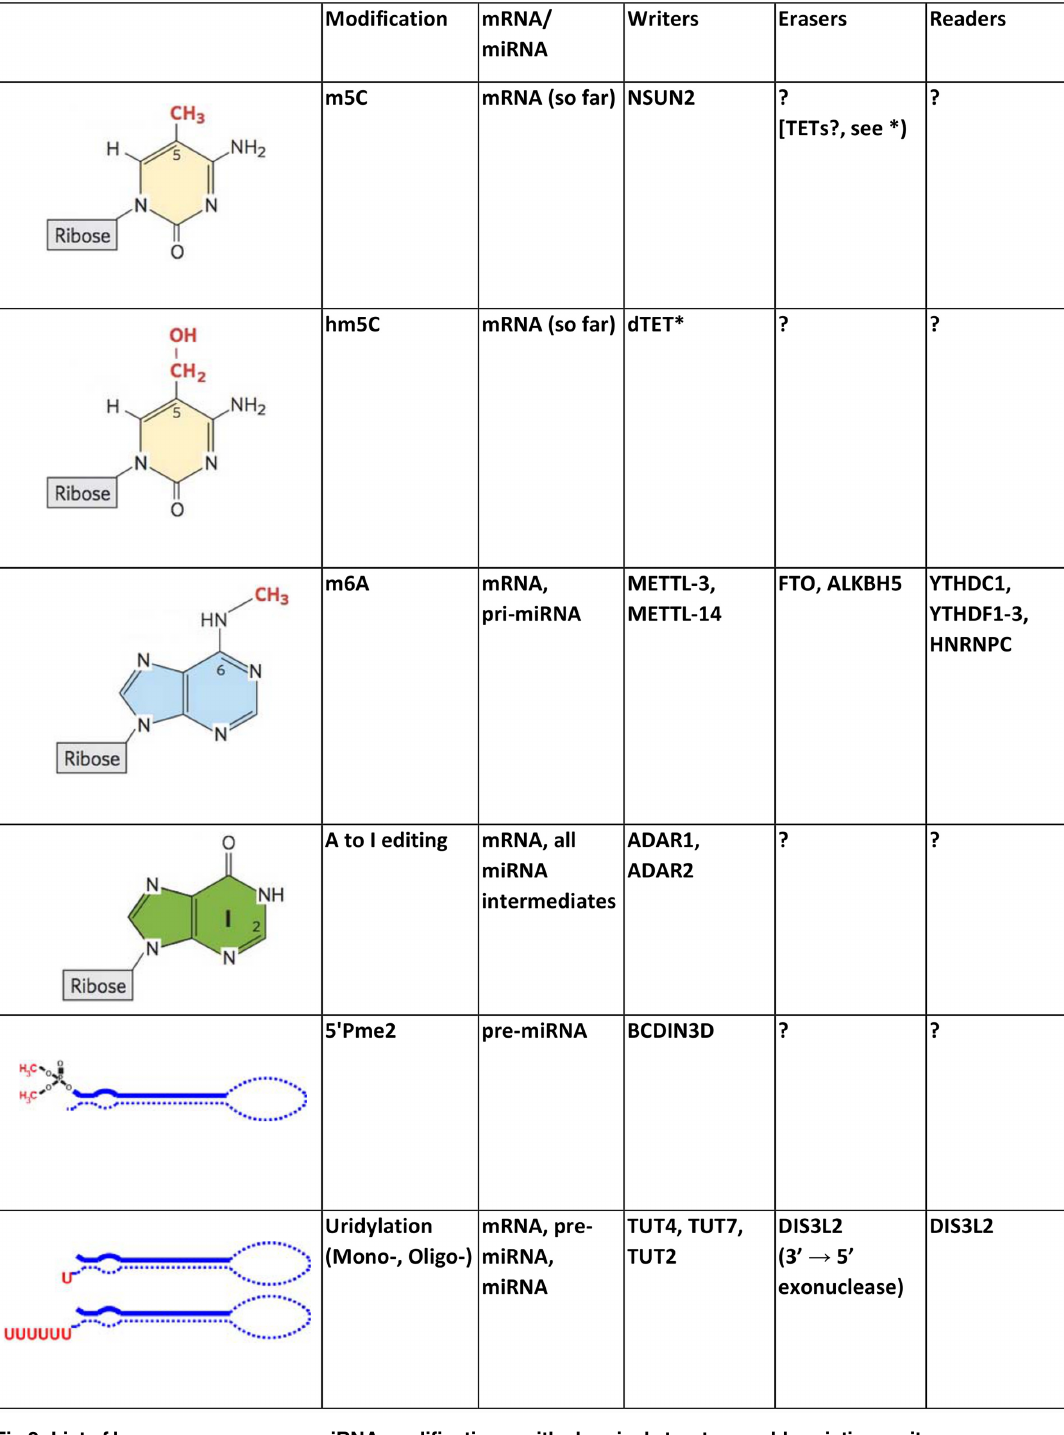
Fig 2. List of known messenger or miRNA modifications, with chemical structures, abbreviation, writers, erasers, and readers. * The Drosophila dTET enzyme has recently been shown to hydroxylate 5meC on RNA [11].